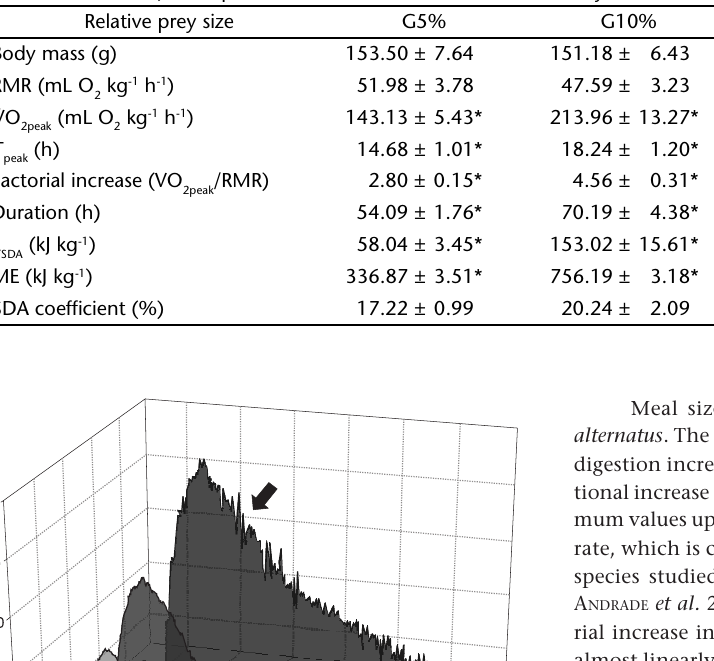
, maximum rate of oxygen uptake during digestion; T , time 2peak peak , and SDA coefficient in the G40% (n SDA